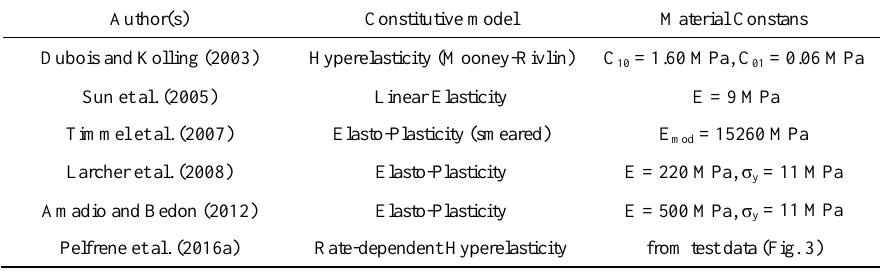
Table 1: Material models for PVB for impact simulation of laminated glass in literature.